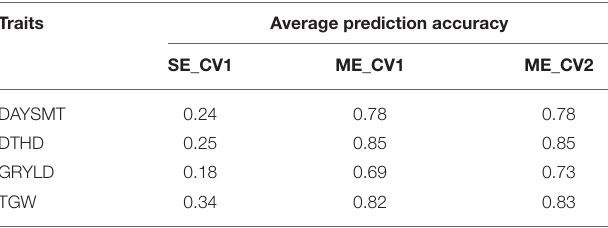
TABLE 4 | Genomic prediction accuracies averaged across four environments for four traits and three modeling scenarios (a) single-environment CV1 (SE_CV1), (b) multi-environment CV1 (ME_CV1), and (c) multi-environment CV2